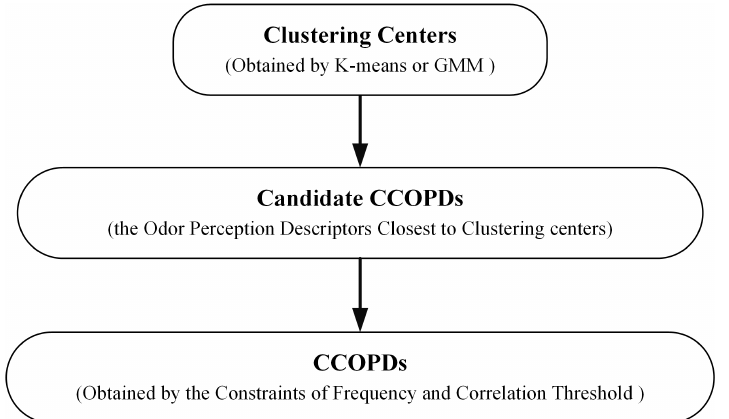
Figure 4. The updating strategy for identifying the CCOPDs from the clustering centers. After obtaining the clustering centers by the clustering algorithm, the odor perception descriptors closest to these clustering centers are chosen as the candidate CCOPDs. Then, under the constraints of frequency and CTs, the CCOPDs are identified from the candidate